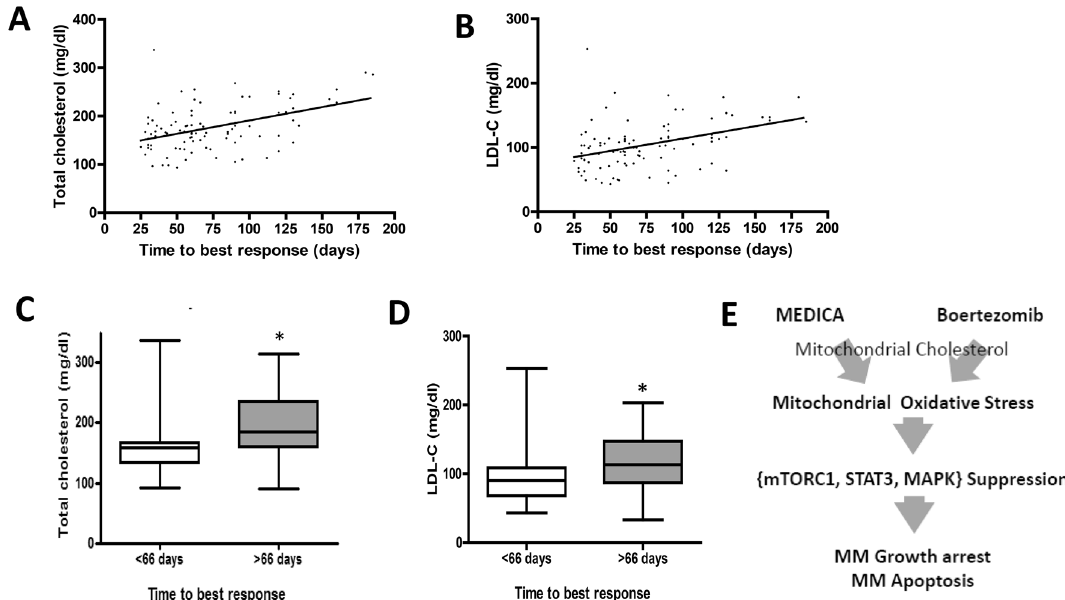
Figure 6. Response of MM patients to bortezomib in correlation to plasma cholesterol levels. (A,B) Plasma cholesterol ( A) and LDL-C ( B) levels of MM patients in correlation to respective time to best-response to bortezomib-based treatment protocol (n = 111). Pearson R = 0.44; R 2 = 0.19 (p < 0.001) for (A) . Pearson R = 0.39; R 2 = 0.15 (p < 0.001) for (B) . ( C,D) Early (< 66 days) and delayed (> 66 days) response time of MM patients to bortezomib in correlation to their plasma cholesterol ( C) and LDL-C ( D) levels (n = 111) . *Significant as compared with time to best-response < 66 days (p < 0.005). ( E) MEDICA and bortezomib converge onto shared